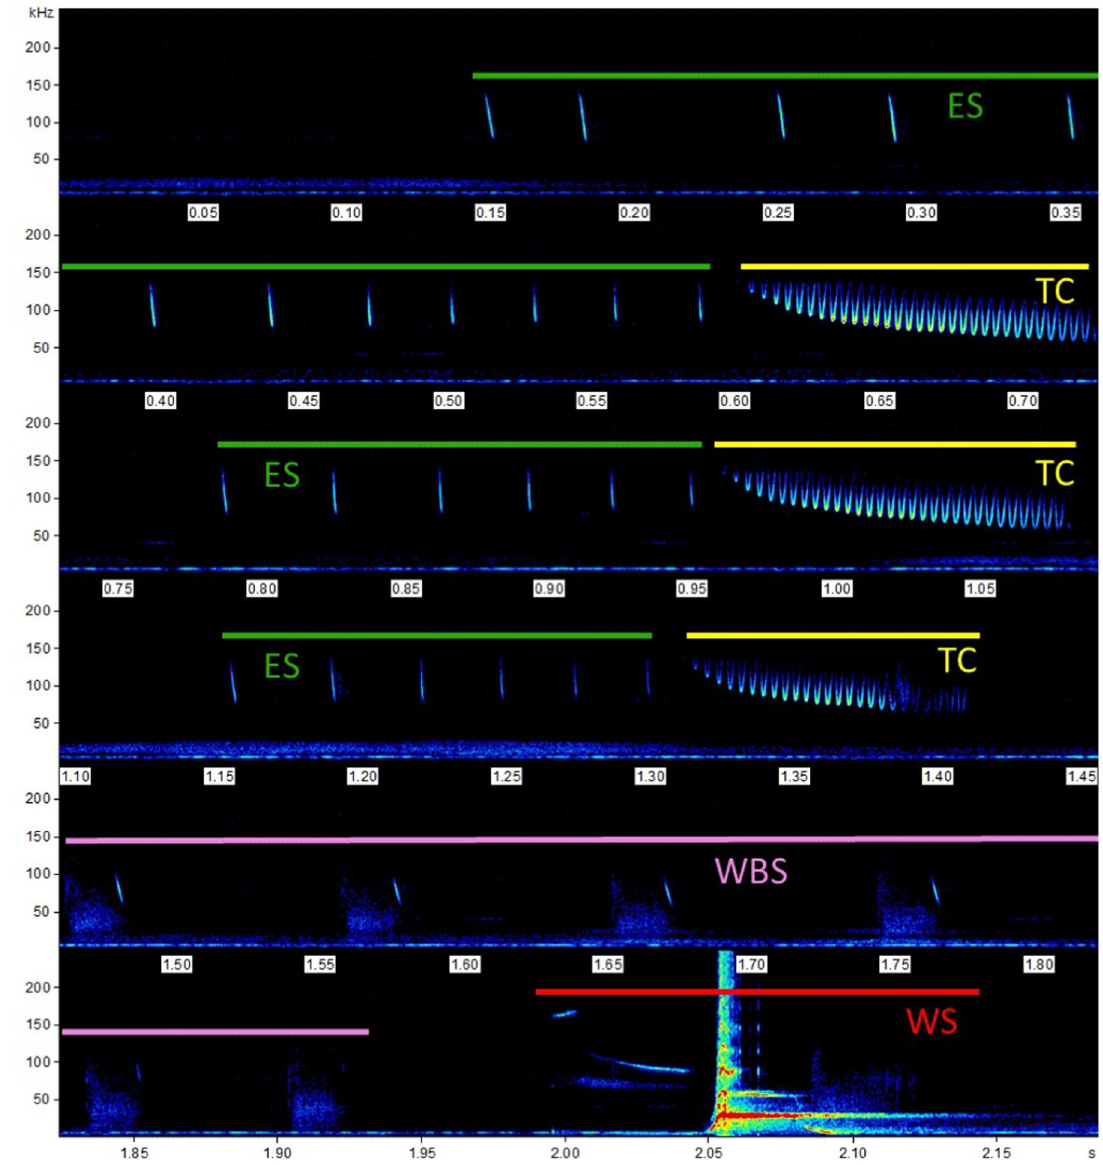
Fig 2. Example of a typical courtship song of Centurio senex . The four major elements are indicated by color bars: echolocation sequences (ES, green bars), trill calls (TC, yellow bars), wing beat sequences (WBS, pink bar), whistle sequence (WS, red bar. Note harmonic artefacts caused by the inevitably overloaded recording of this always relatively loud element.). The repetition of echolocation and trill sequences resulted in this example in an 8 element song. (Parameters for all spectrograms: Blackman Window, FFT 512, frame size 100%, overlap 75%, resulting in a spectral resolution of 977 Hz and a temporal resolution of 0.256 ms).